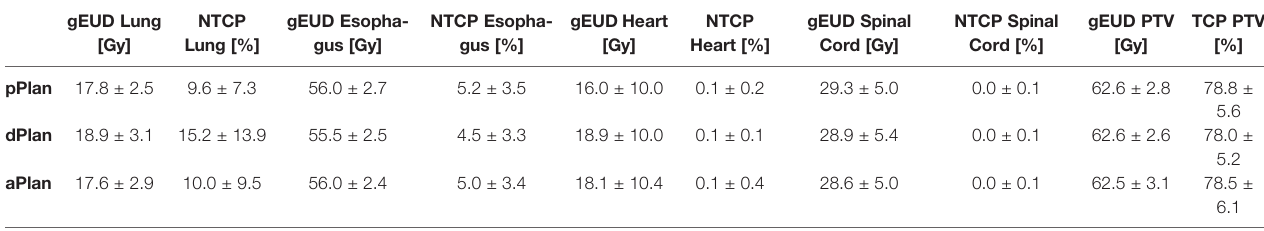
TABLE 5 | Generalized equivalent uniform dose (gEUD), normal tissue complication probability (NTCP) and tumor control probability (TCP) in organs at risk and planning target volume (PTV) for primary plan (pPlan), actually delivered plan (dPlan) and adapted plan (aPlan). All values given as mean ± standard deviation. gEUD Lung